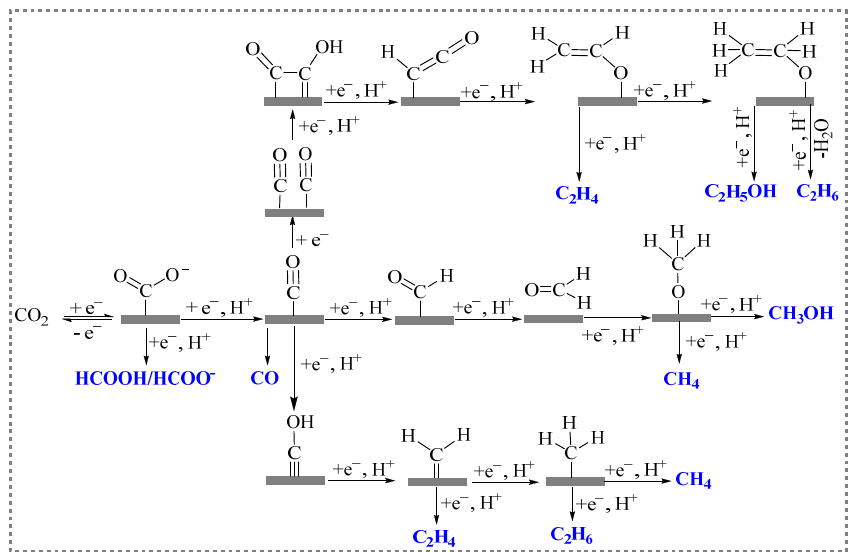
Figure 3. Possible reaction pathways for the electroreduction of CO 2 .